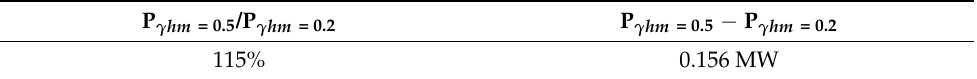
Figure 9. Instantaneous power required to overcome the magnetic braking forces and its components (Equation (11)) at v = 100 m/s. Table 3. Comparison of ratio and absolute difference of required power for vehicle traveling with velocity = 100 m/s.